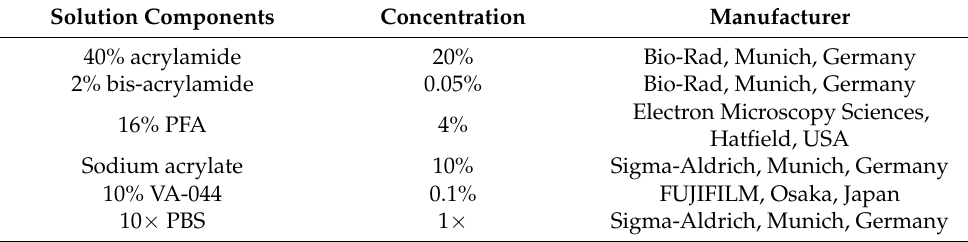
Table 1. Preparation of the amplifying hydrogel solution